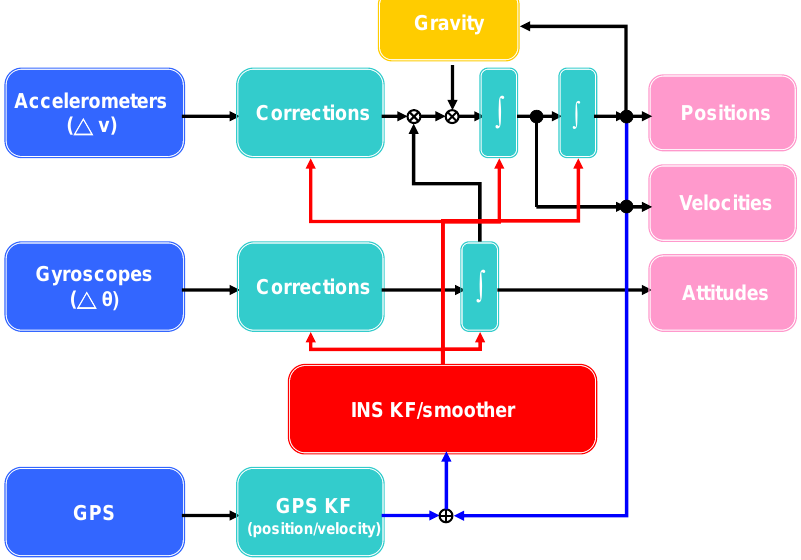
Figure 3. A loosely coupled INS/GPS integration architecture (closed